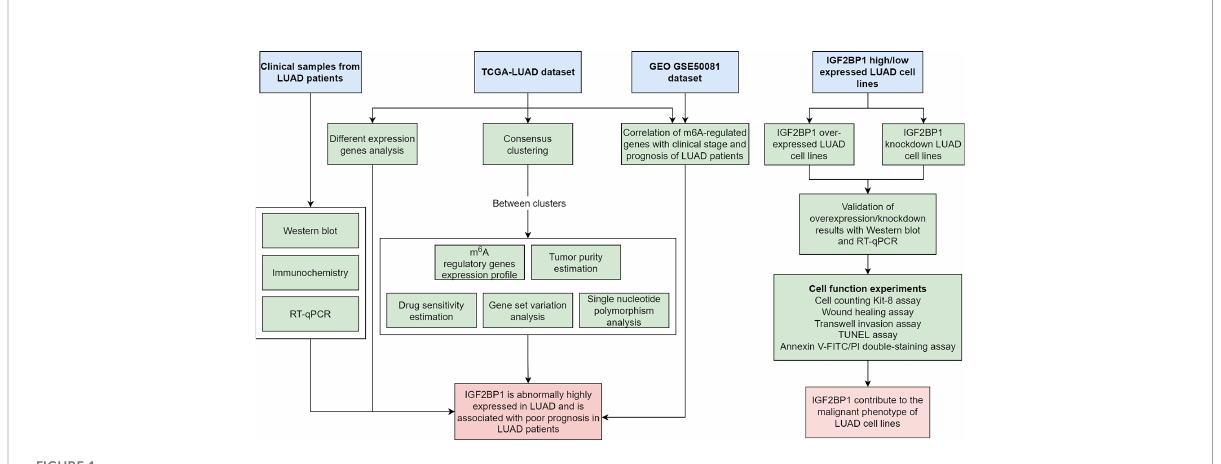
FIGURE 1 Flowchart of the bioinformatics analysis and